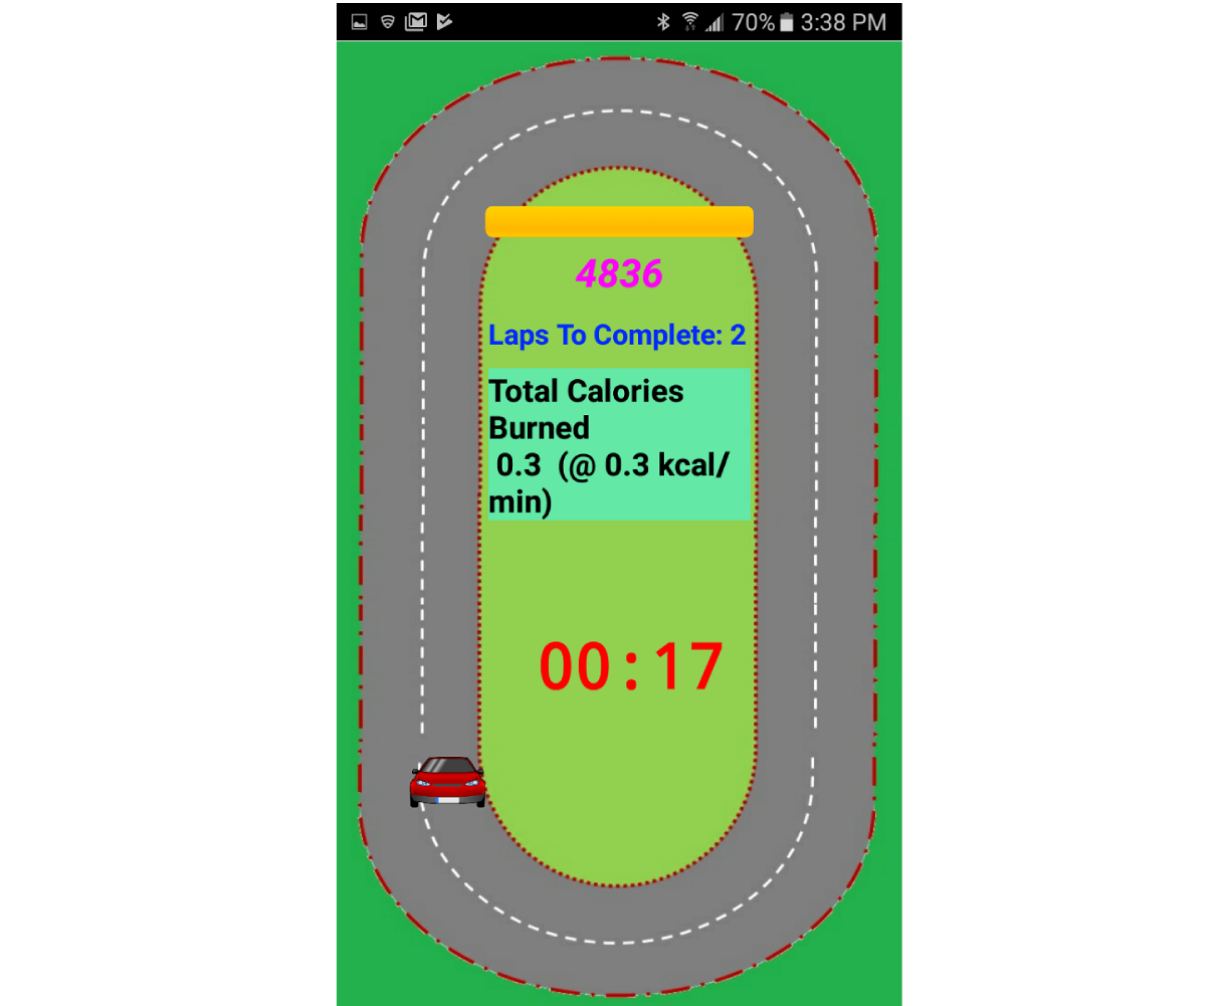
Figure 6. Single-player track game: Angular speed of the car is proportional to the EMG (level for a punch being detected increases). EMG: